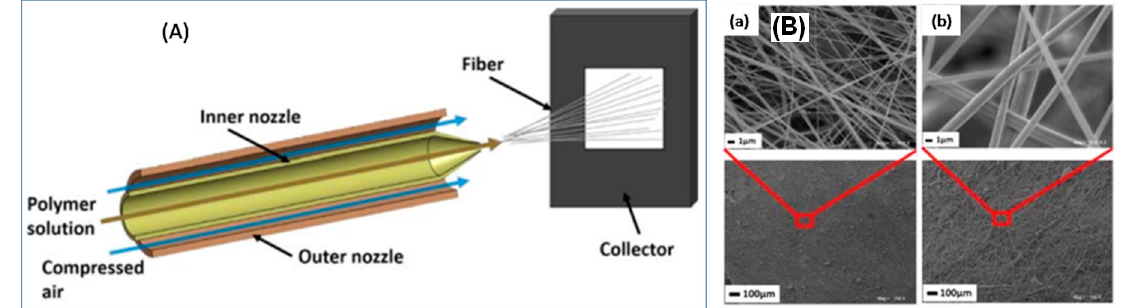
Figure 4. ( A ) Experiment setup of solution blowing and SEM of PU-NFs; ( B ) PU-NF nonwovens with different concentration: ( a ) 10% ( b ) 20%.